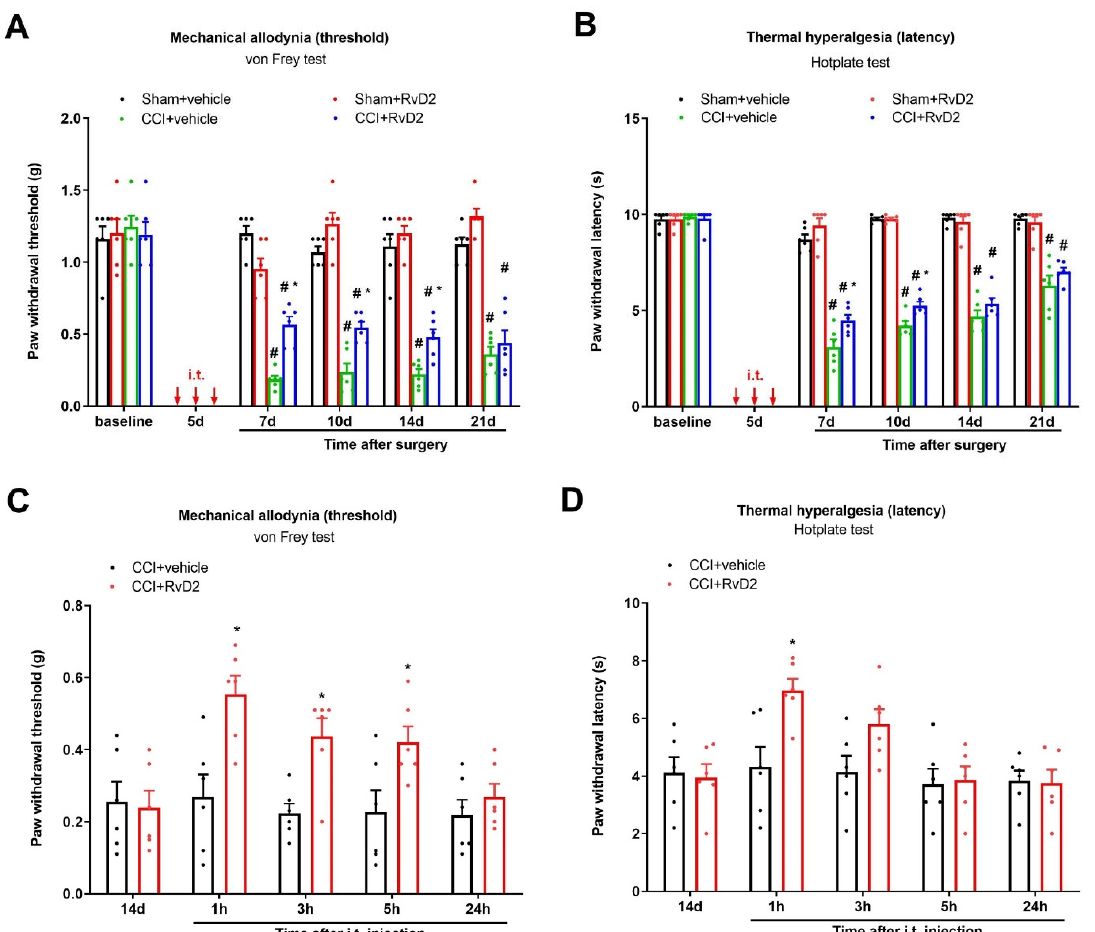
Figure 1. Intrathecal treatment with RvD2 reduces the production and persistence of neuropathic pain caused by peripheral nerves injuries. ( A , B ) Intrathecal RvD2 (500 ng) was given daily on days 4, 5 and 6 (indicated by red arrows) following sham and CCI operations. ( C , D ) RvD2 (i.t., 500 ng) was given on day 14 following CCI surgeries. Mechanical allodynia was evaluated by paw withdrawal threshold ( A , B ) using von Frey experiments, and thermal hyperalgesia was evaluated by paw withdrawal latency ( B , D ) using hotplate experiments. Behavioral results are expressed as the mean ± SEM ( n = 6) and compared using two-way ANOVA followed by Bonferroni multiple comparisons. # p < 0.05 vs. group sham + vehicle. * p < 0.05 vs. group CCI + vehicle. i.t. = intrathecal injection.